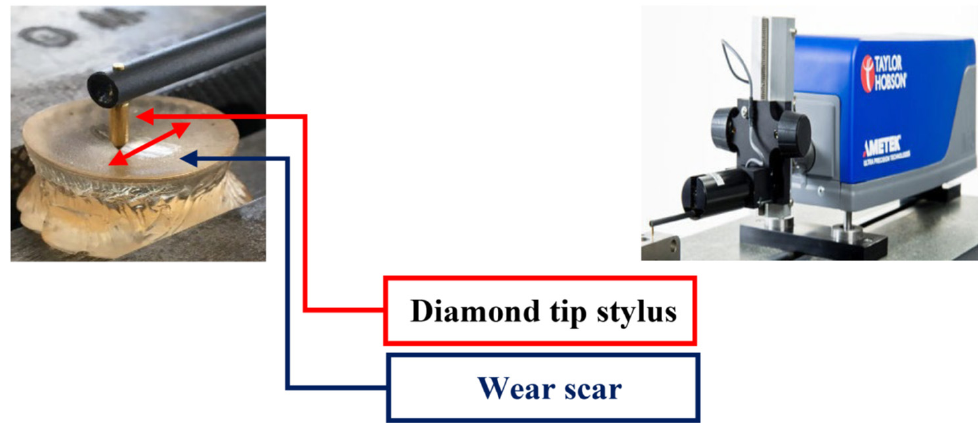
Figure 2. Stylus profilometer to measure the wear scars.